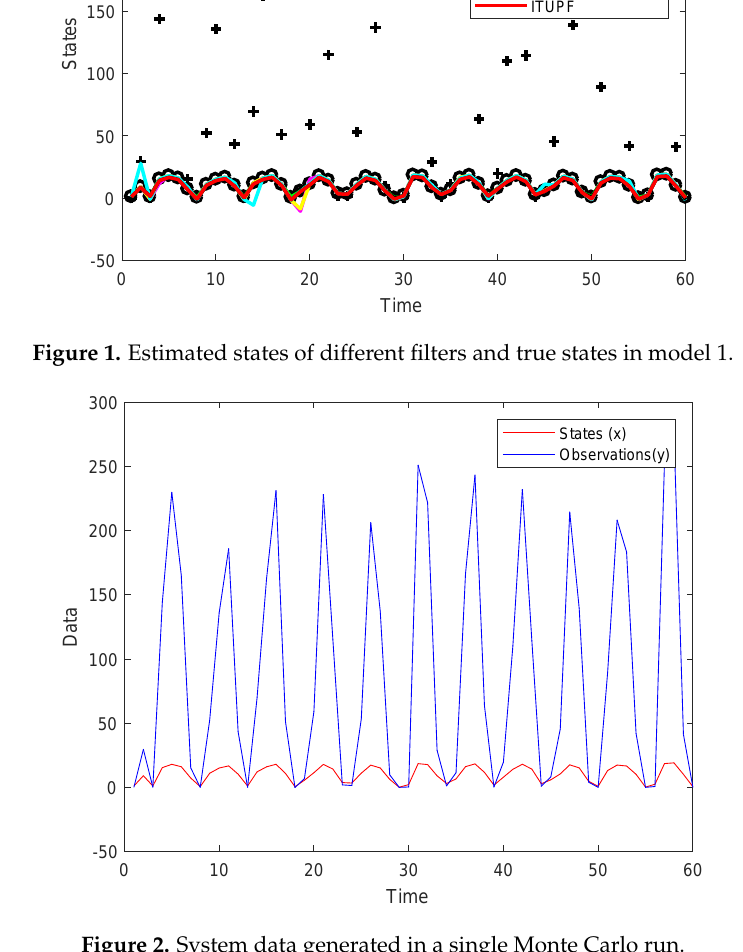
Figure 2. System data generated in a single Monte Carlo